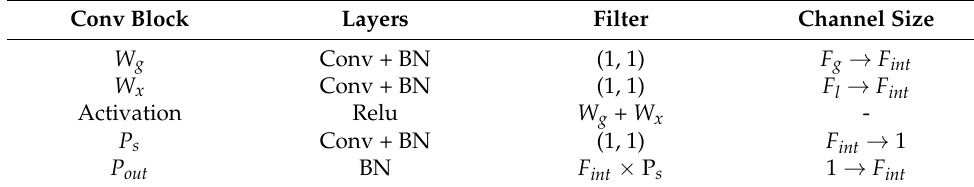
Table 2. Parameters of